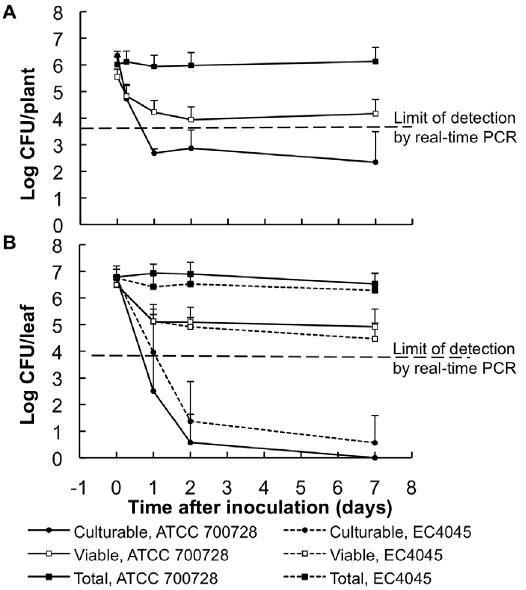
Figure 3. Survival of E.coli O157:H7 ATCC 700728 and EC4045 on inoculated lettuce in a growth chamber. E. coli O157:H7 cell amounts were measured by plate count (culturable), real-time PCR (total), and PMA real-time PCR (viable) methods. Plants were inoculated with a spray bottle (A) or by drop (B) and incubated at a relative humidity of 30%. The mean 6 stdev of 15 lettuce plants or leaves at each sampling time for three replicate experiments is shown.